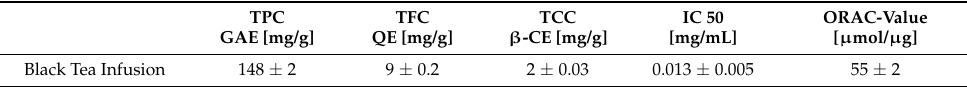
Table 1. Characterization overview of the used control extract BT infusion. Total polyphenol content (TPC) is expressed in gallic acid equivalents (GAE), total flavonoid content (TFC) is expressed in quercetin equivalents (QE) and total carotenoid content (TCC) is expressed in β -carotene equivalents ( β -CE) of black tea (BT) infusion.